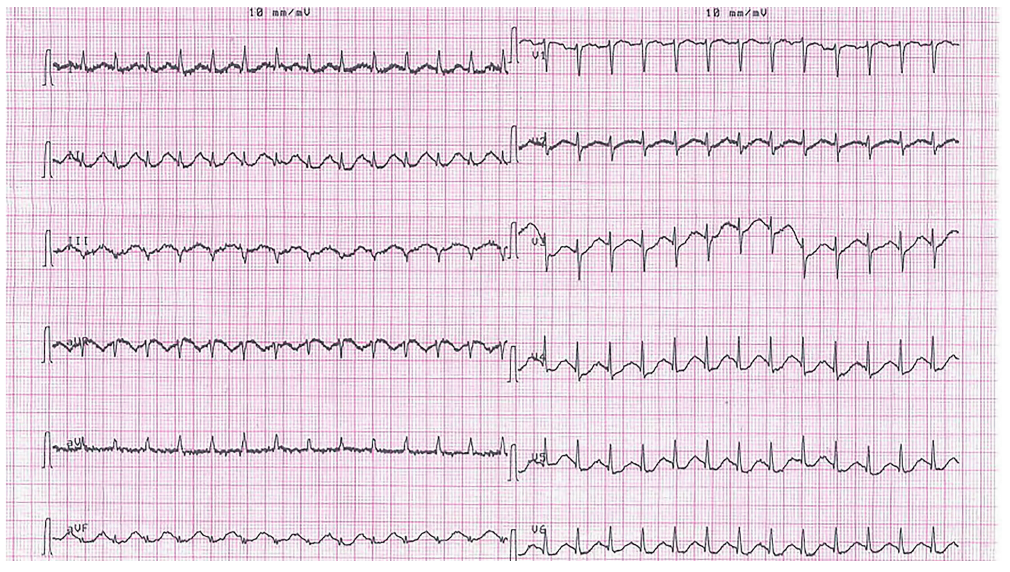
Figure 1 - A 12-lead electrocardiogram (EKG) showing a regular narrow complex supraventricular tachycardia at 167 beats per minute (bpm) that occurred after intraurethral lidocaine